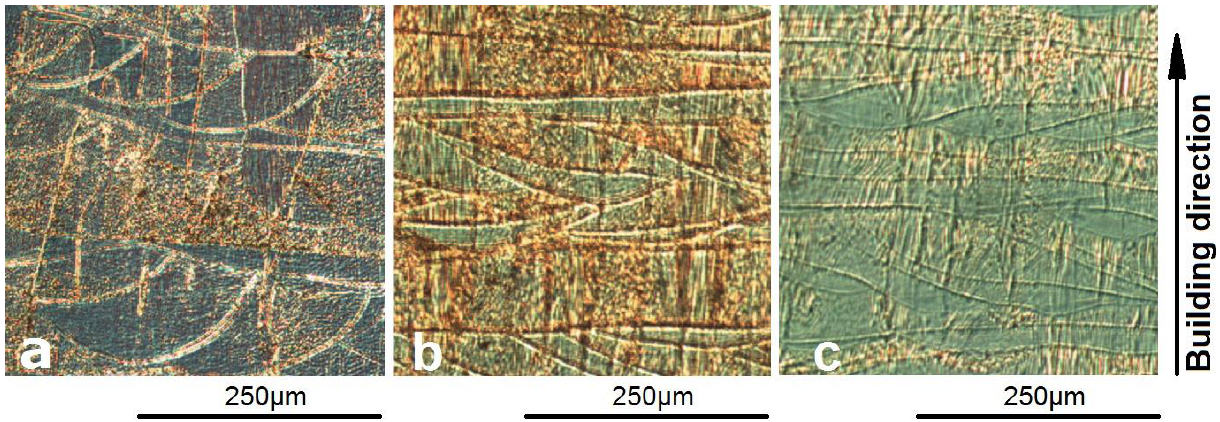
Figure 5. Melt tracks from samples with different process settings: ( a ) sample a (1000 mm/s), ( b ) sample b (3000 mm/s), ( c ) sample c (5000 mm/s).